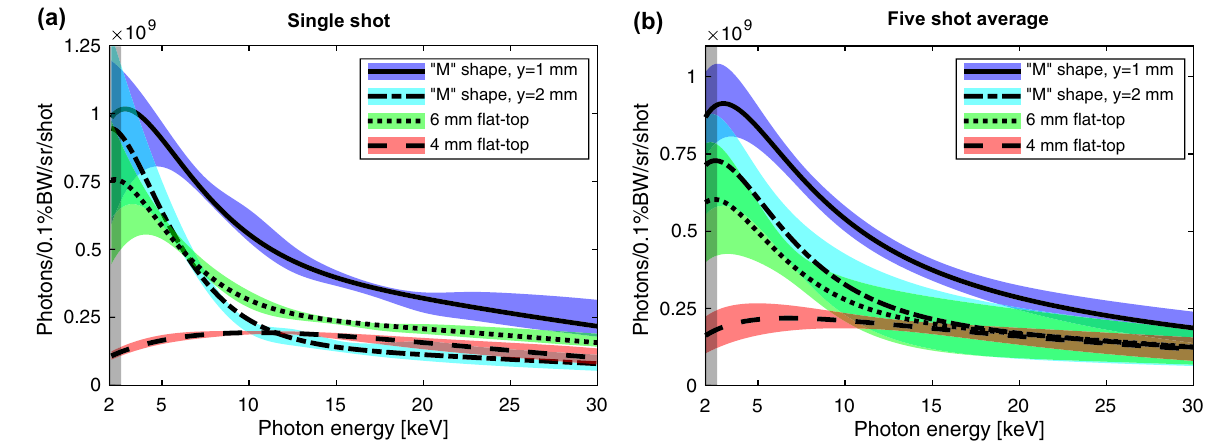
Figure 2. Measured X-ray Spectra. ( a ) Spectral intensity extracted from the filter transmission for a flat-top 4 mm jet (red, dashed), a flat-top 6 mm jet (green, dotted) and the “M”-shaped jet for an interaction distance above the nozzle of y 1 = 1 mm (blue, solid) and y 2 = 2 mm (cyan, dash-dotted) for single shots. ( b ) A five- shot average. The fit parameters for the five-shot average are given in Table 1. The colored shades represent the confidence bands obtained through a statistical analysis of a large set of Monte-Carlo (MC) simulations. The confidence bands for the single shots indicate a point-wise one-sigma band of bootstrapped datasets. The confidence band for the averaged shots are obtained by uncertainty propagation using the individual shot uncertainties (see Methods section). The spectral observation range is limited to 2.7–30 keV (indicated through vertical gray shades) due to filter transmission and the quantum efficiency of the CCD